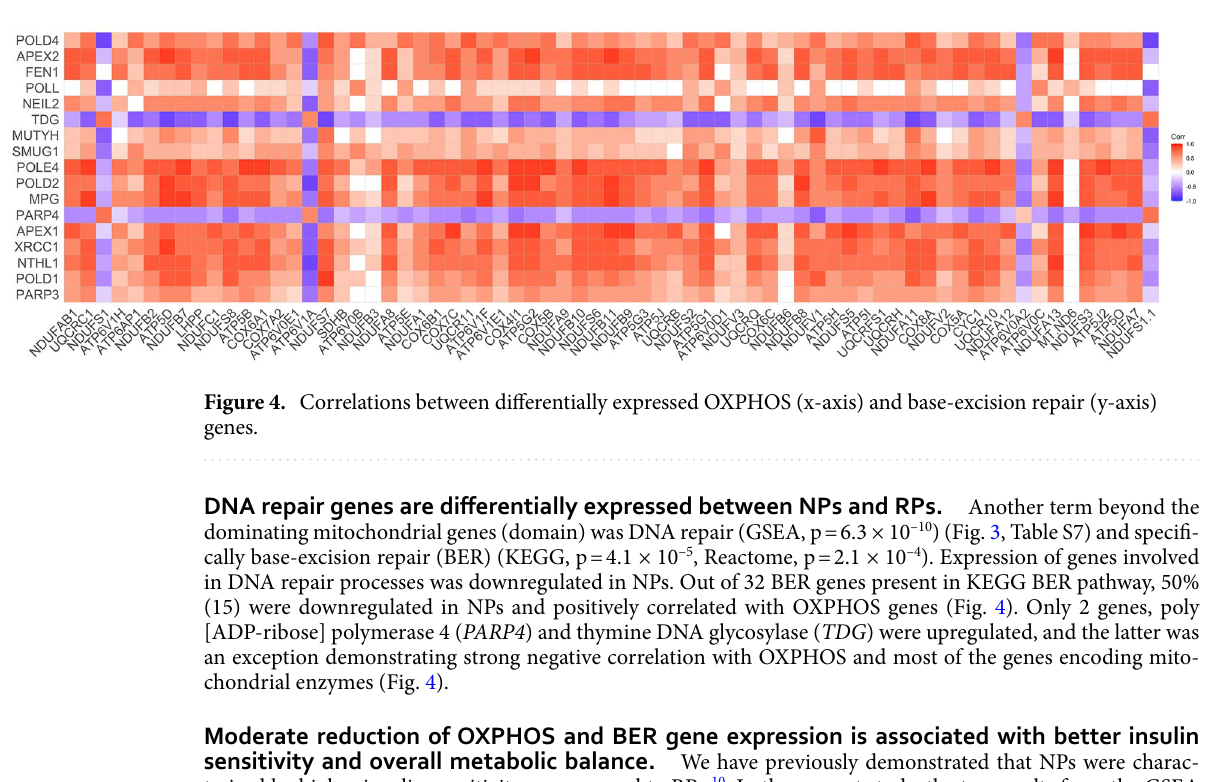
Figure 3. Functional enrichment plots showing variation of statistical significance with z-score based on log- fold change for biological pathway and terms from various databases. (A) Over representation analysis results for KEGG pathways, (B) over representation analysis results for GO terms, (C) gene-set enrichment analysis results (GSEA—HALLMARK genesets). Size of the bubbles are correlated with total number of genes in the pathway. Colors indicate similar pathways. Results are shown for age-adjusted DE analysis.